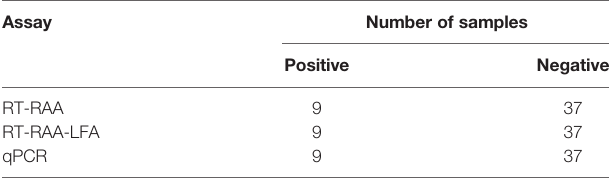
TABLE 4 | Detection in clinical samples by RT-RAA, RT-RAA-LFA and qPCR.